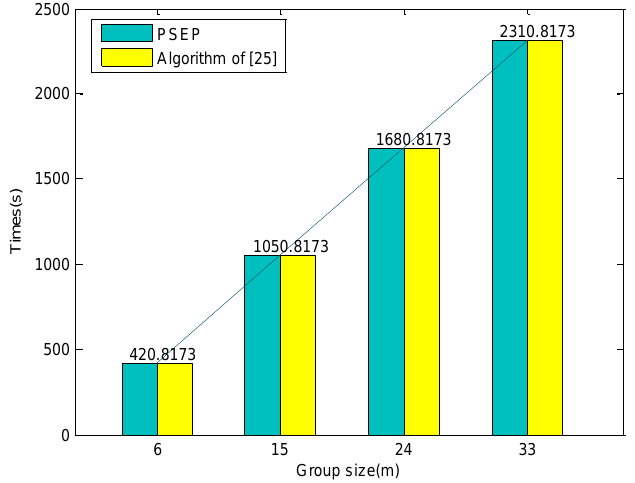
Figure 10. Comparison of their total escape time varying with the group size.